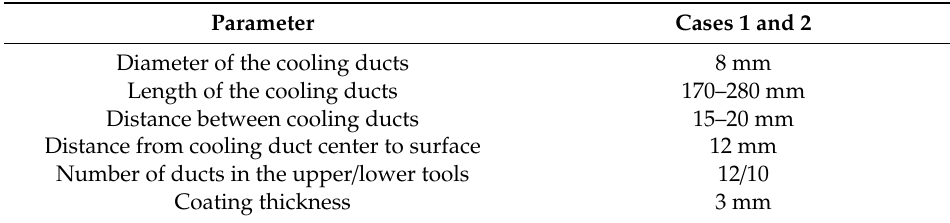
Table 3. Geometric parameters of the simulated tools.